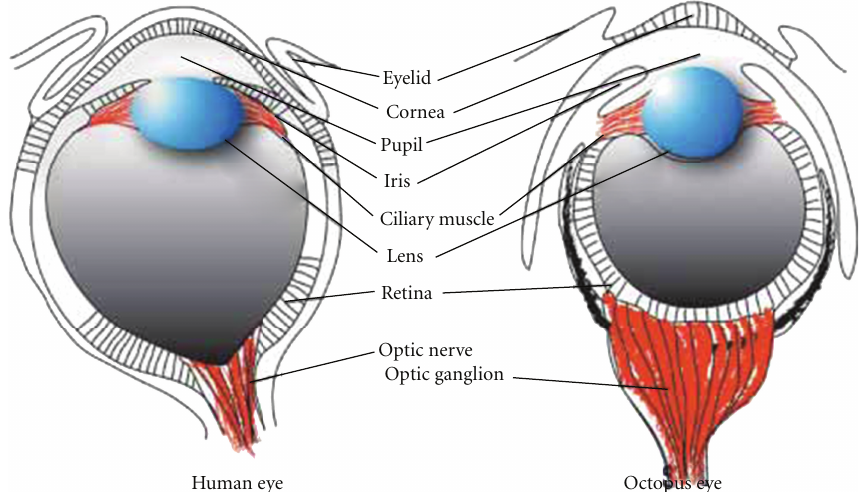
Figure 1: Human and octopus camera eyes have very similar morphology. Essentially the whole gene set needed to make this complex structure was already selected in the common ancestor of the bilaterians, long before camera eyes appeared. This poses a problem for “convergent evolution”. See Ogura et al.